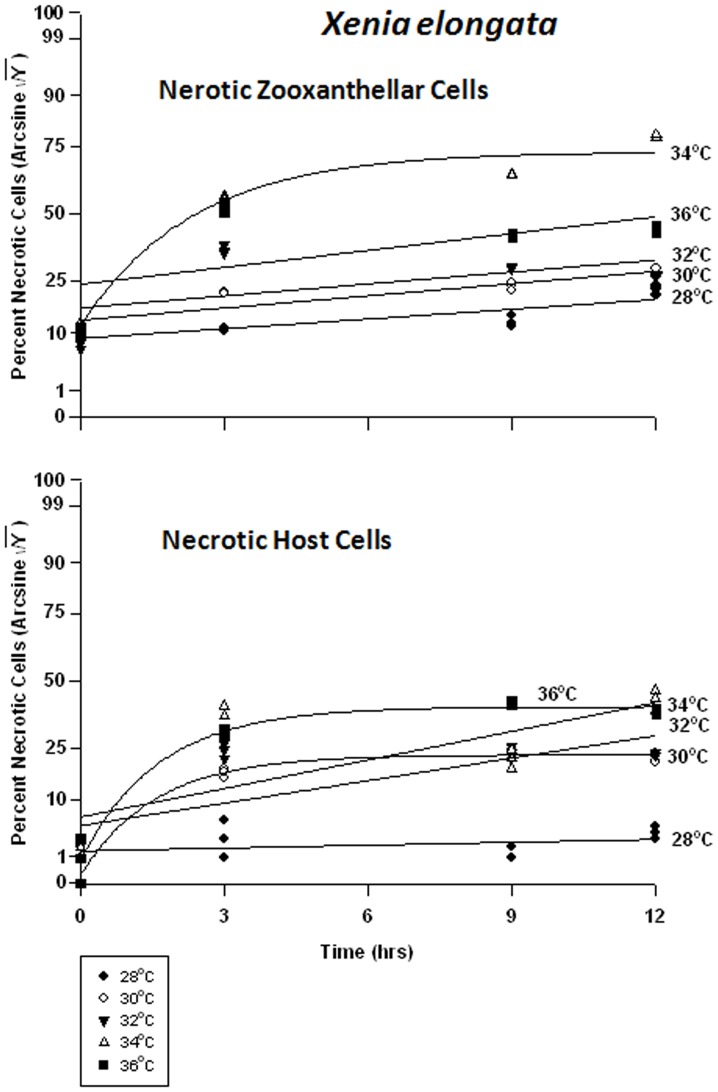
Effects of seawater temperature on percent necrotic endosymbiotic Symbiodinium and host coral Xenia elongata cells. In-hospite
, collected over a12 h period. Corals exposed to 28 to 36°C treatments. • = 28°C; ○ = 30°C;▾ = 32°C; Δ = 34°C; ▪ = 36°C. Data transformed by arcsine for normalization purposes. Zooxanthellae: Positive non-linear responses in all cases of 28–36°C (p<0.001); linear trends shown for 28, 30, 32 and 36°C cases to facilitate comparison (Y = 0.722X +17.659, Y = 0.905+21.732, Y = 0.889X +24.473, and Y = 1.258X +29.726, respectively). Non-linear response shown for 34°C (Y = 20.375+38.923*(1−e[−0.427X]). Host Cells: No significant linear regression at 28°C (p>0.05); i.e., regression coefficient not significantly different than “0”. Significant positive non-linear responses at 30–36°C (p<0.001). Relationships at 30°C and 36°C described as Y = 1.911+26.890*(1−e[−0.640X]) and Y = 5.232+34.343*(1−e[−0.612X]), respectively. Linear trends shown in cases of 32 and 34°C to facilitate comparison (Y = 1.678X +12.990 and Y = 2.132X +14.895, respectively).